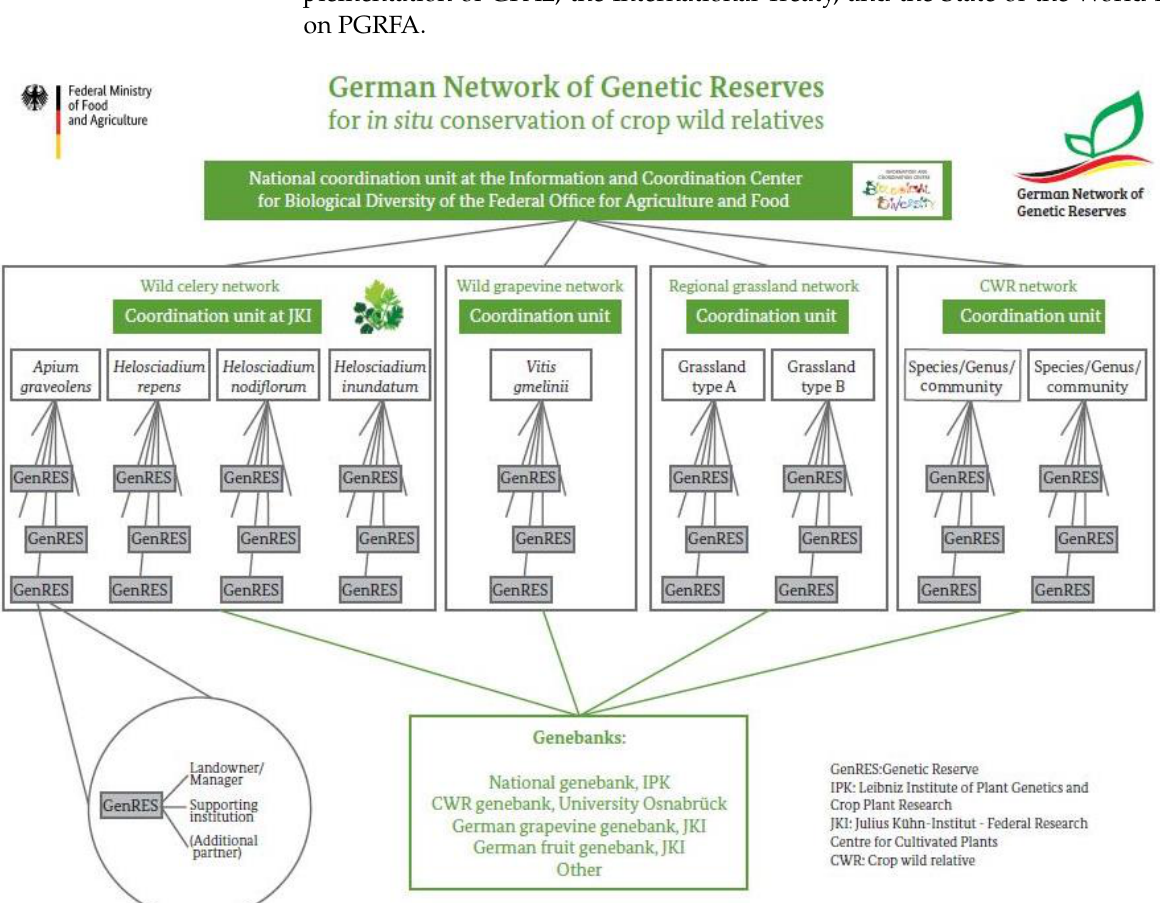
Figure 4. Structure of the German Network of Genetic Reserves. The first CWR specific network was the wild celery network established in